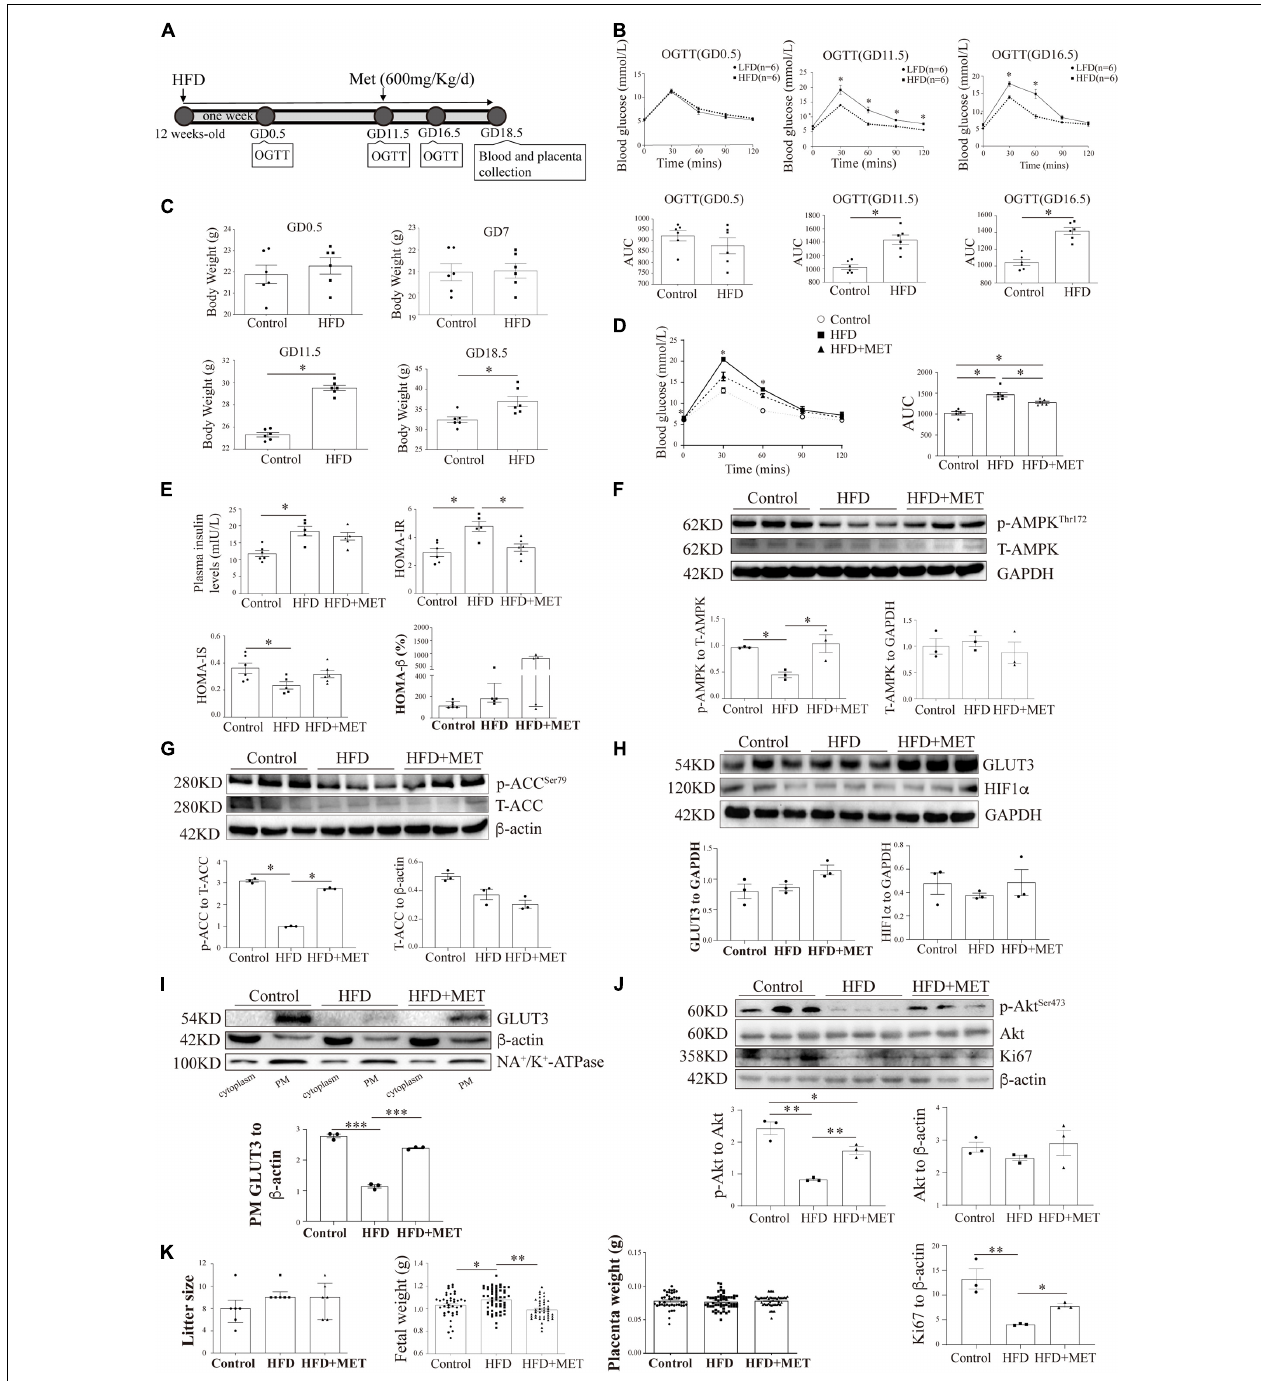
FIGURE 6 | The pharmacological activation of AMPK rescues the shuttling of GLUT3 in the placentas of HFD-induced GDM mice. (A) Timeline of the treatments and measurements. (B) OGTT and AUC values on GD0.5, GD11.5 and GD16.5 ( n = 6). (C) Body weights on GD0.5, GD7, GD11.5 and GD18.5 ( n = 6). (D) OGTT and AUC values on GD16.5 ( n = 5–6). (E) Plasma insulin levels and HOMA-IR, HOMA-IS and HOMA- β scores on GD18.5 ( n = 5–6/group). (F) Western blot analysis of the p-AMPK and AMPK levels in the placentas from each group ( n = 8 from 3 dams). (G) p-ACC and ACC levels in the placentas ( n = 8 from 3 dams). (H) GLUT3 and HIF-1 α protein levels in the mouse placentas ( n = 8 from 3 dams). (I) Membrane-bound GLUT3 protein levels in each group ( n = 8 from 3 dams). PM GLUT3 was normalized to NA + /K + -ATPase. (J) p-Akt, Akt and Ki67 protein levels in the mouse placentas. (K) Litter sizes, fetal birth weights, and placental weights obtained for each group ( n = 6–68/group). The data that are presented as the means ± SEMs are annotated in normal font, and Student’s t -test was used between two groups while ordinary ANOVA test was used among multiple groups. The data presented as the medians (IQRs) are shown in bold font, and Mann-Whitney test was used between two groups while Kruskal-Wallis test was used among multiple groups. ∗ p < 0.05, ∗∗ p < 0.01, and ∗∗∗ p < 0.001.